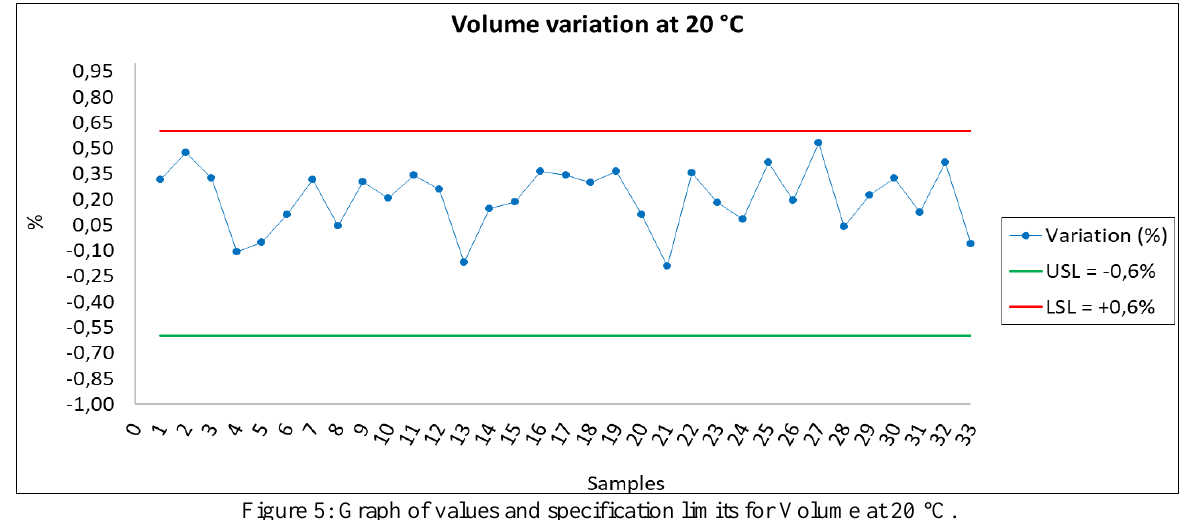
Figure 5: Graph of values and specification limits for Volume at 20